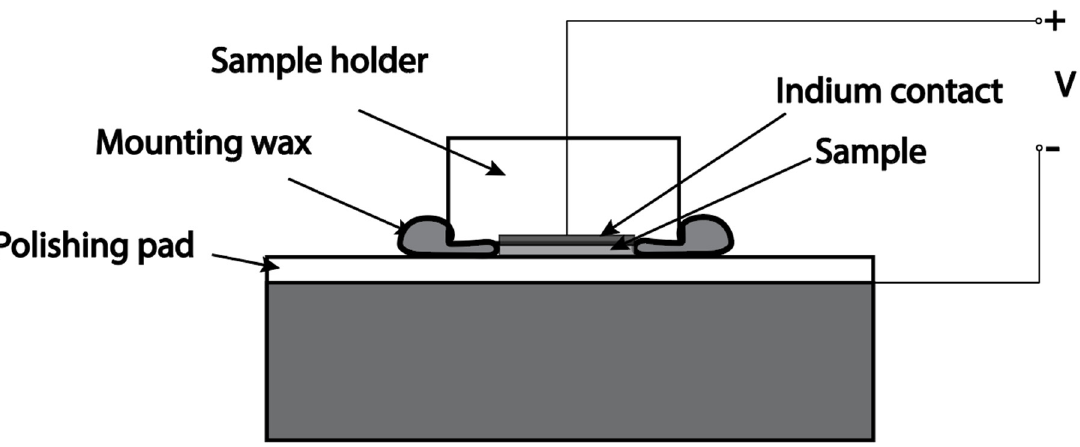
Figure 14. Schematics of electrochemical